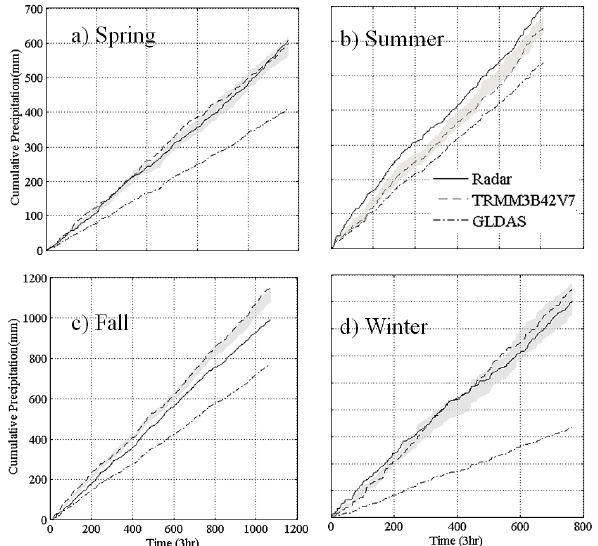
Figure 5. Cumulative precipitation values of the validation events in the four seasons; the shaded area indicates the 20 ensemble mem- bers of downscaled and error-corrected GLDAS data.